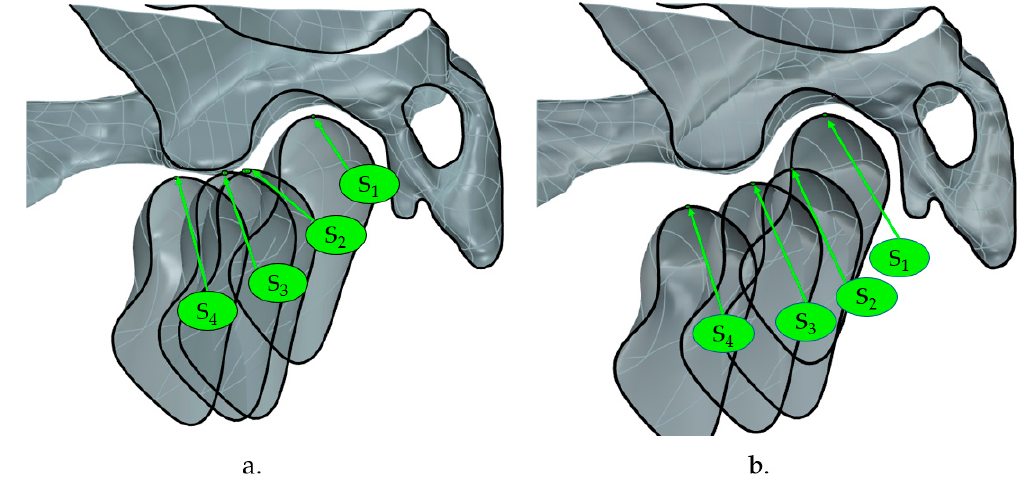
Figure 7. The total condylar trajectory of MAD1 ( a ) and MAD2 ( b ) in correspondence of the following configurations: Rest, Lift, Head-to-head, and Max Advancement.